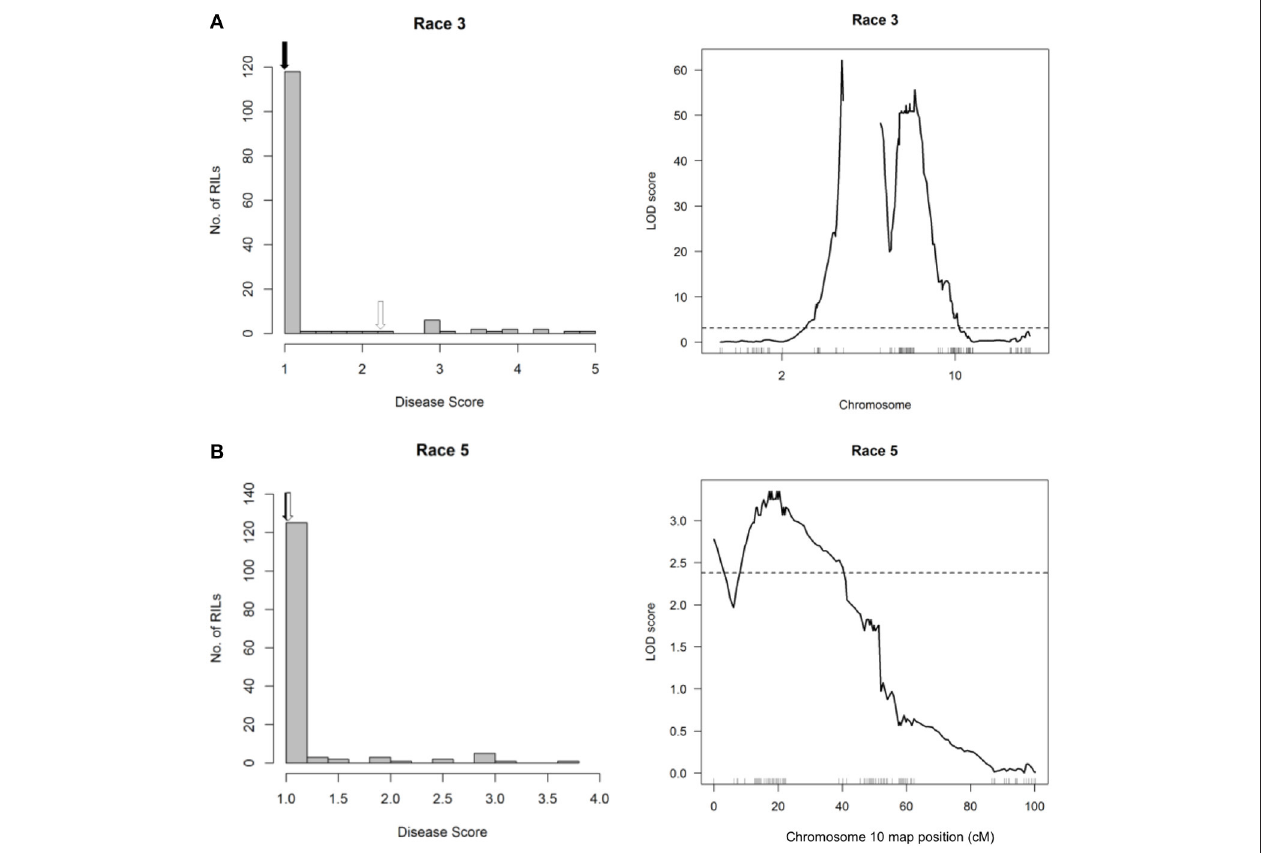
FIGURE 8 | Resistance mapping in the Phaseolus vulgaris Rojo × CAL 143 (RC) recombinant inbred population following separate inoculations with (A) Race 3 or (B) Race 5 of Pseudomonas syringae pv. phaseolicola does not detect a QTL interval on Pv04. (Left graphs) Distribution of interaction phenotypes exhibited by RC inbreds in glasshouse experiments. The phenotype scale ranges from highly resistant (score 1.0) to fully susceptible (score 5.0). White arrows denote the mean disease score for CAL 143 and black arrows denote the mean disease score for Rojo. (Right graphs) LOD profiles obtained by one-dimensional and two-dimensional genome scans. QTL models were fitted and refined using the multiple imputation method. Dashed lines denote significance at the 0.05 probability